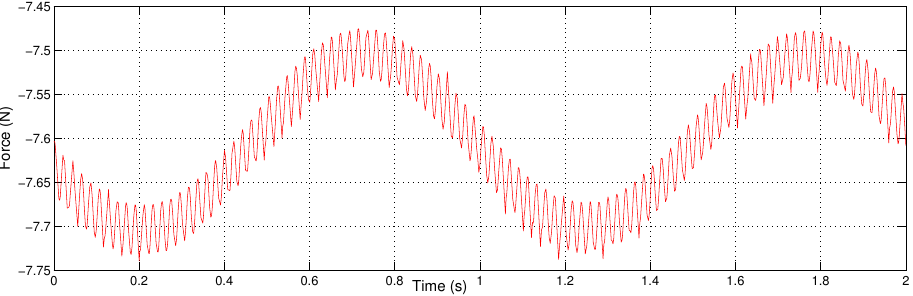
Figure 5. y -axis representation of cutting